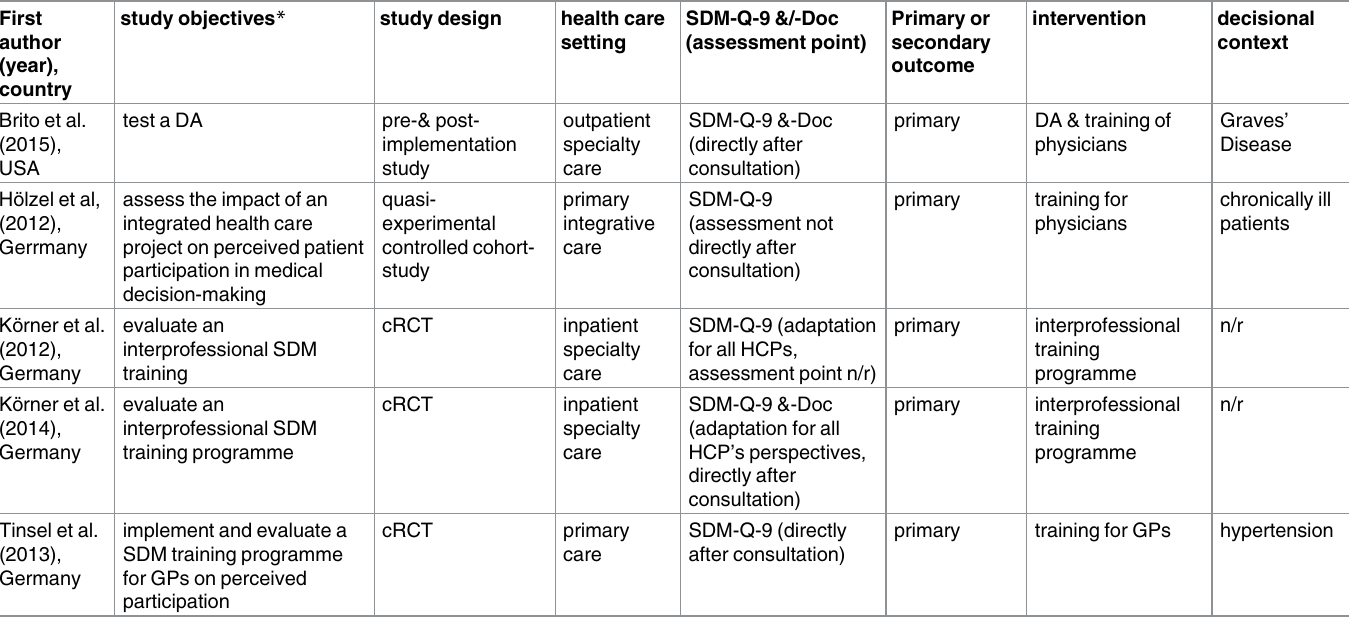
Table 2. Characteristics of the included original